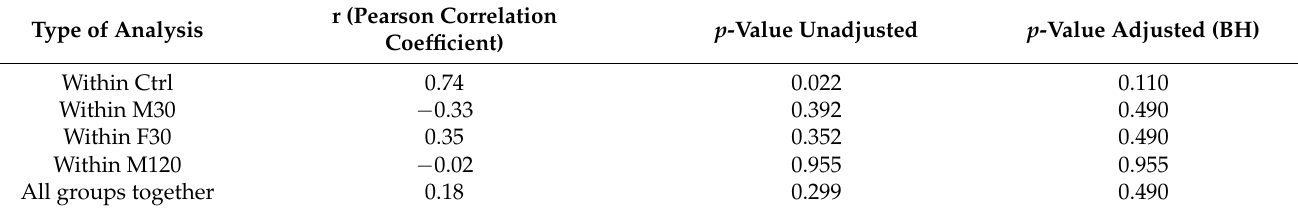
Table 2. Correlation between serum IL-1 β [pg/mL] and EL [pg/mL] concentrations.